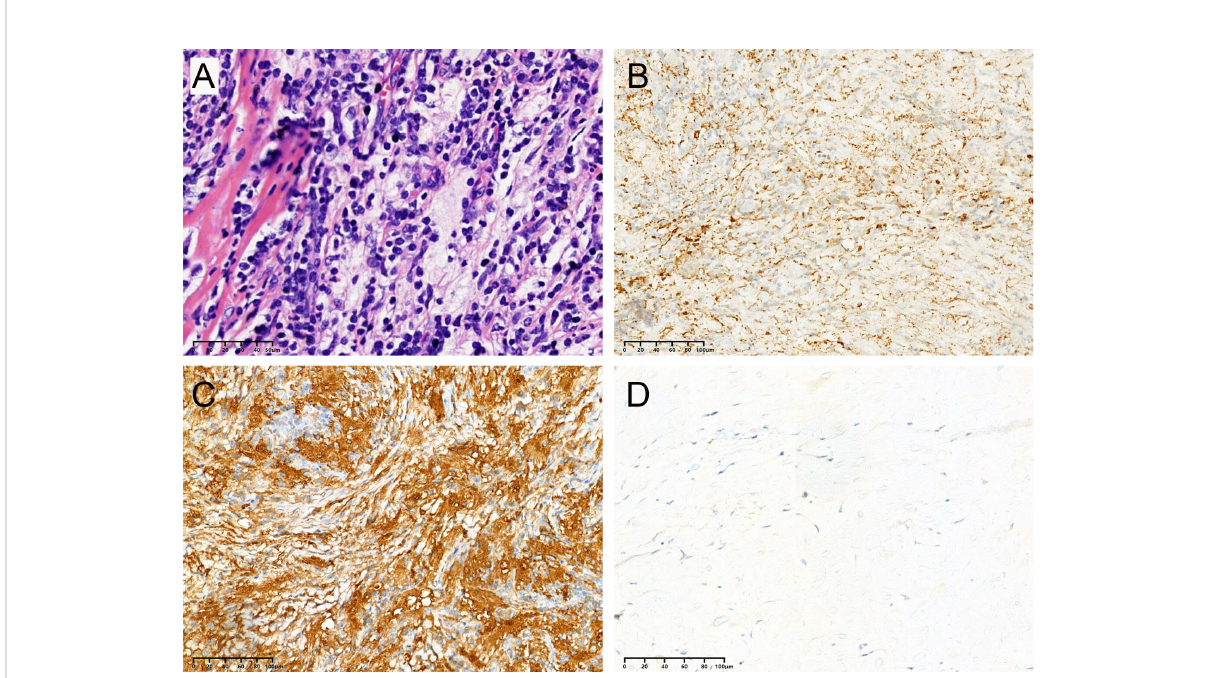
FIGURE 6 All cases in this series had similar morphologic features, and representative images are shown. (A) Biopsies contained an abnormal, vaguely nodular, polymorphous lymphohistiocytic in fi ltrate composed of abundant, loosely cohesive large histiocytes admixed with numerous small mature lymphocytes and plasma cells (hematoxylin and eosin). The immunohistochemical results showed positive expression of CD68 (B) and S-100 (C) protein but not CD1a (D)